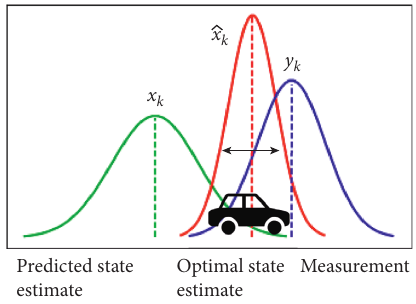
Figure 4: Working principle of Kalman